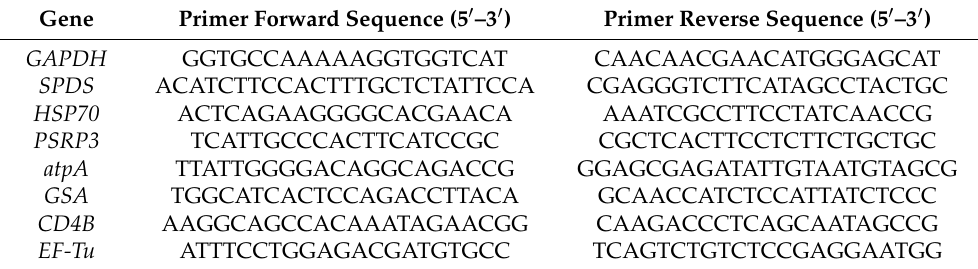
Table 2. Primers for